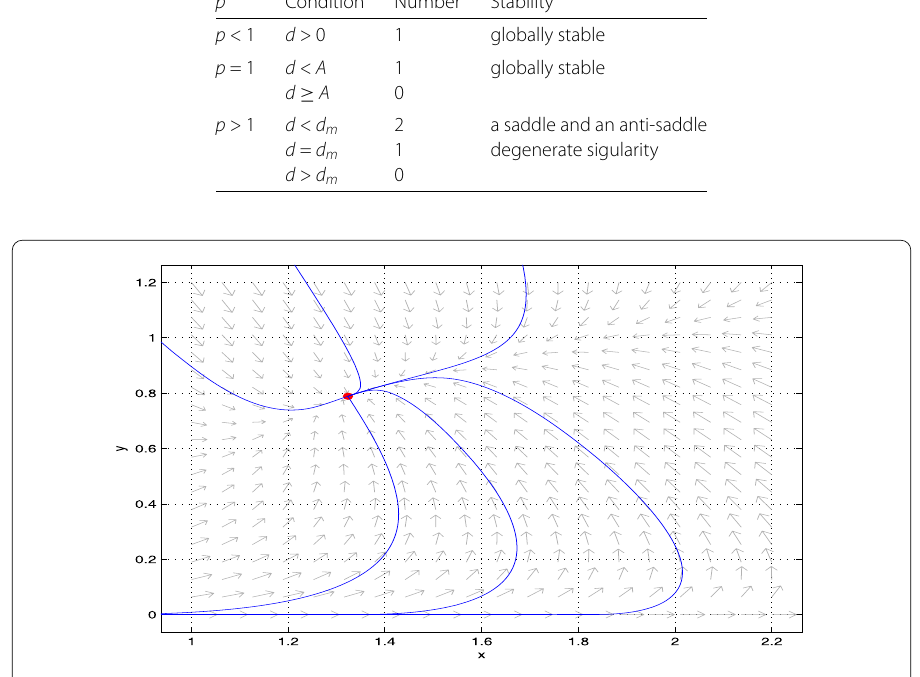
Figure 3 The global stability of ˆ E when p = 1/2, q = 3, A = 1, d = 0.1, α = 1, γ =